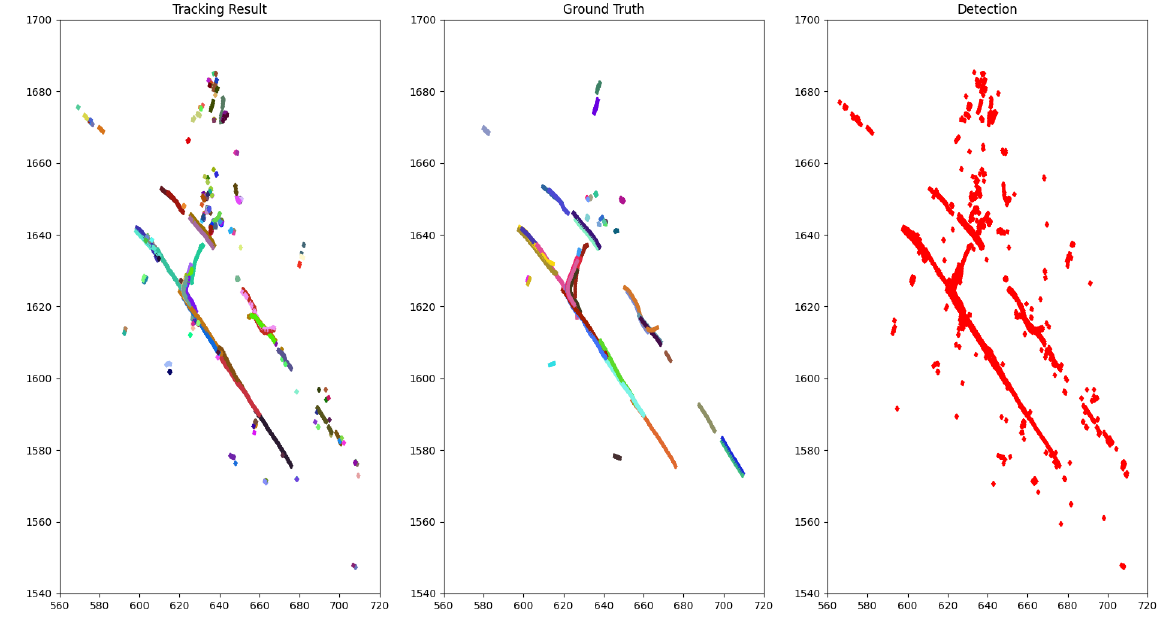
Figure 4. The bird-eye view of tracking result for class pedestrian compared to the ground truth of scene 0103 (NuScenes) accumulated through time. Each dot represents a pedestrian and each color is associated with a track ID.